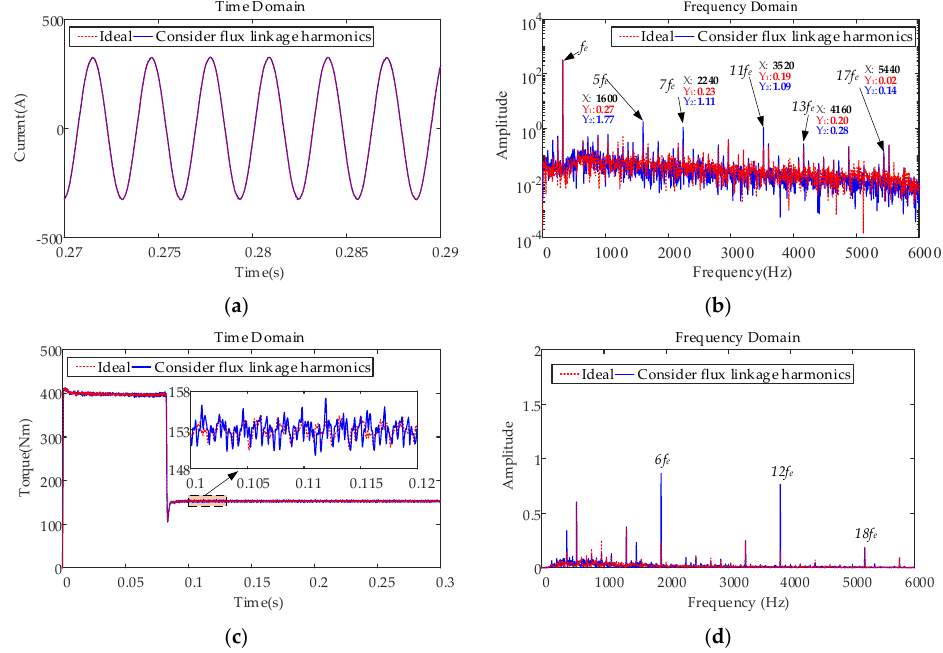
Figure 14. Comparison results of current and electromagnetic torque: ( a ) time domain of A ‐ phase current; ( b ) frequency domain of A ‐ phase current; ( c ) time domain of electromagnetic torque; ( d ) current; ( b ) frequency domain of A-phase current; ( c ) time domain of electromagnetic torque; frequency domain of electromagnetic torque. ( d ) frequency domain of electromagnetic